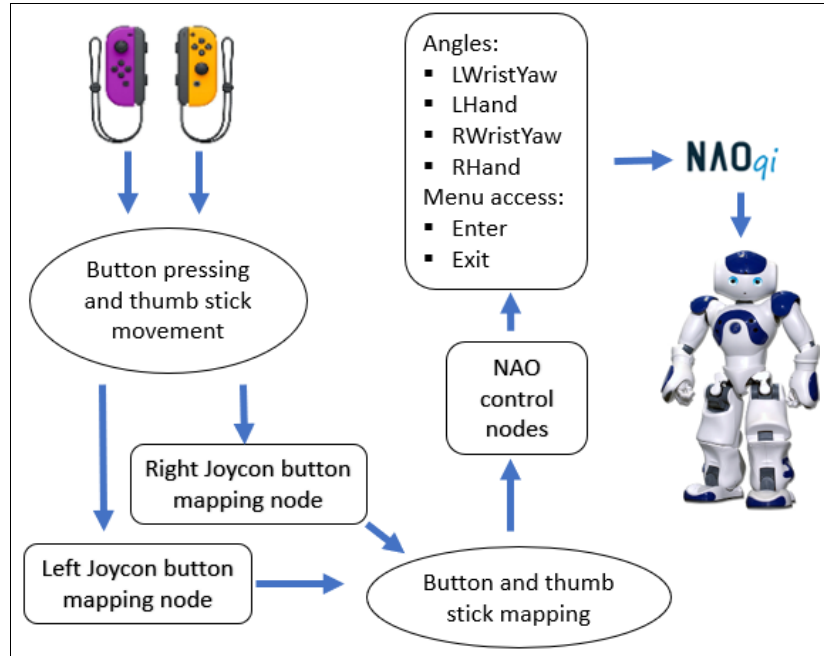
Figure 9. Software architecture of the data acquisition with the Joycon controllers.